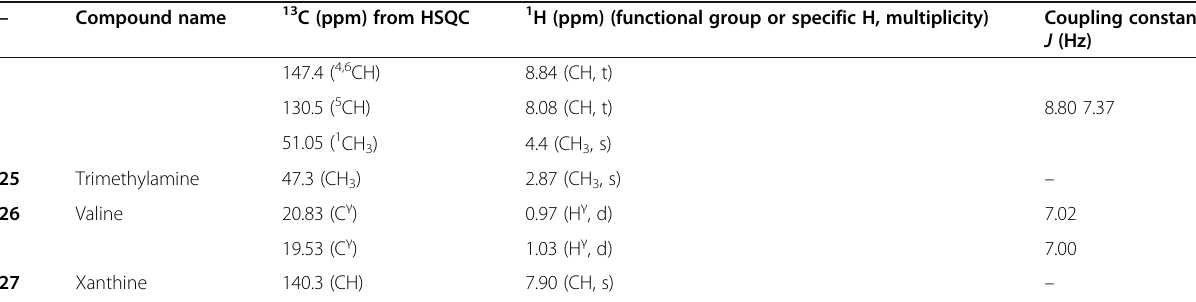
Table 1 list of metabolites identified in the polar extract of A. pubescens shoot (Continued)